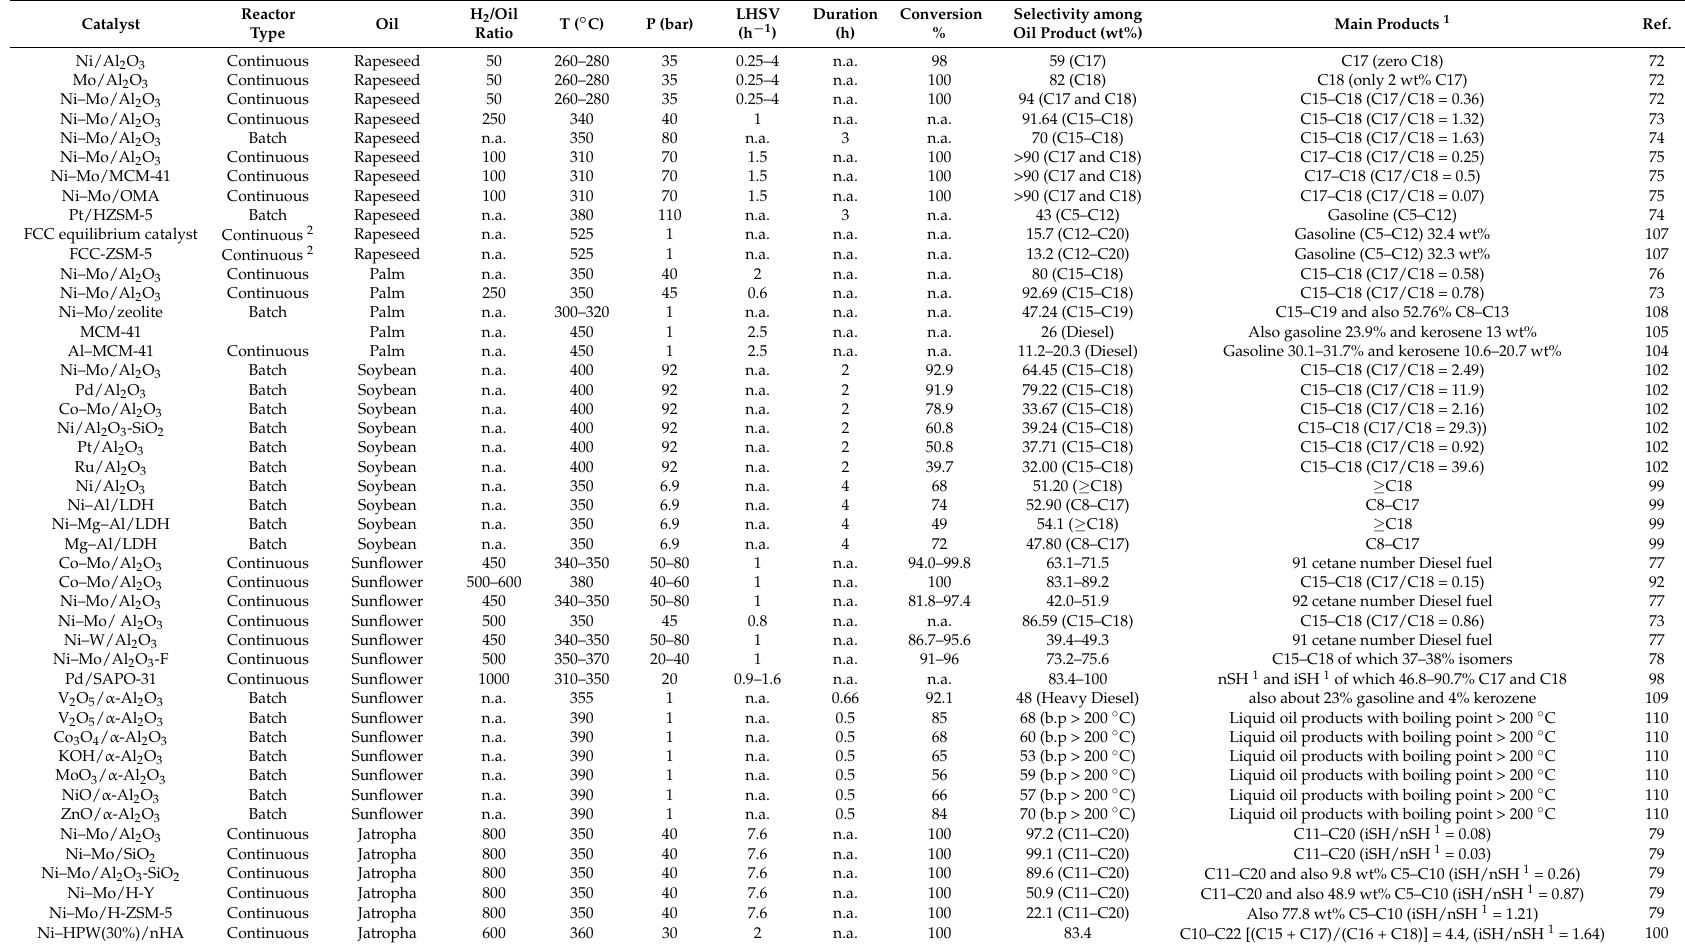
Table 5. Catalysis research on hydrotreating of vegetable oils, waste cooking oils, greases and animal fats. LHSV: Liquid Hour Space Velocity. LDH: Layered Double Hydroxide. n.a.: Not available. b.p: Boiling